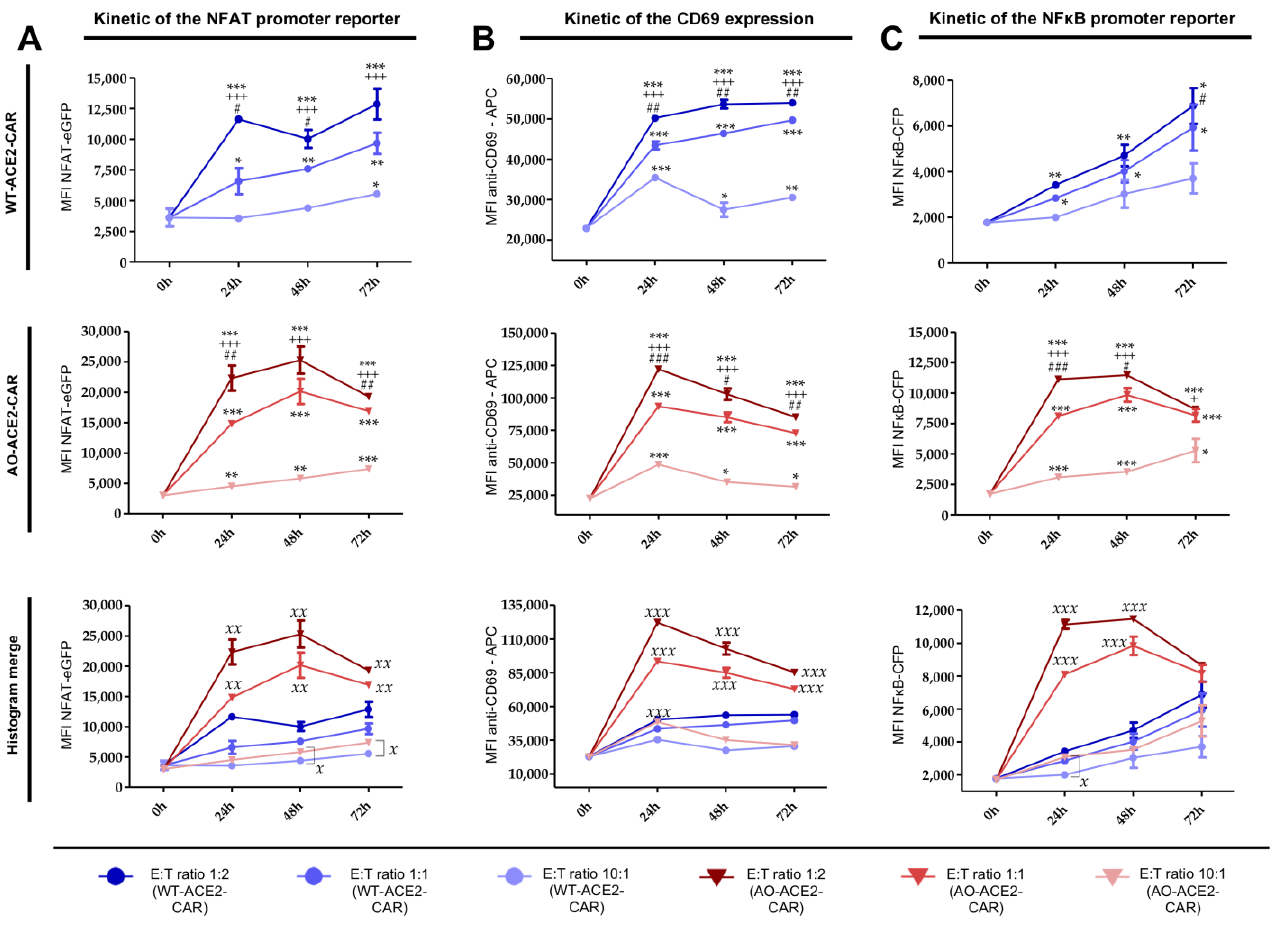
Figure 7. Kinetics of the activation of ACE2-CAR-TPR cells upon culture with Spike-expressing A549 cells. Kinetics of CD69 upregulation ( B ) as well as NF κ B ( C ) or NFAT promoter activation ( A ) upon culture with Spike-expressing A549 cells. In the two first rows, MFI values of the corresponding activation markers for WT-CAR-TPR cells (top) and AO-CAR-TPR cells (middle) at different ratios were shown while in the last row, values from the 1:1 effector:target ratios for all cell types are compared. Each symbol represents mean ± SEM of three independent experiments performed in triplicate. Statistical analysis is indicated for each condition vs. non-stimulated cells (* p < 0.05, ** p < 0.01, *** p < 0.001), ratio 2:1 vs. 1:1 for each condition ( # p < 0.05, ## p < 0.01, ### p < 0.001); ratio 2:1 vs. 10:1 for each condition ( + p < 0.05, +++ p < 0.001); WT-CAR vs. AO-CAR for each ratio ( x p < 0.05, xx